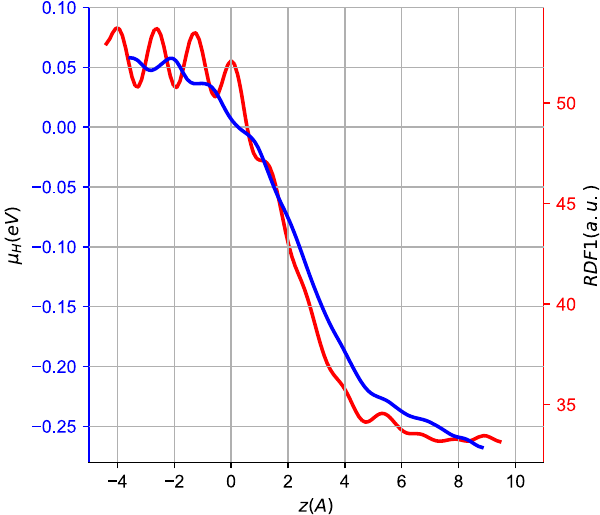
Fig. 2 Silicon density and hydrogen chemical potential at the c-Si/a-Si:H interface. The hydrogen chemical potential μ H ( z ) (blue), and the Si density as indicated by the fi rst peak height of the radial distribution function RDF1( z ) (red) across the interface of the Si HJ are shown. μ H ( z ) tracks the Si density remarkably closely, making is plausible that the Si density gradient is the cause of the H chemical potential gradient.